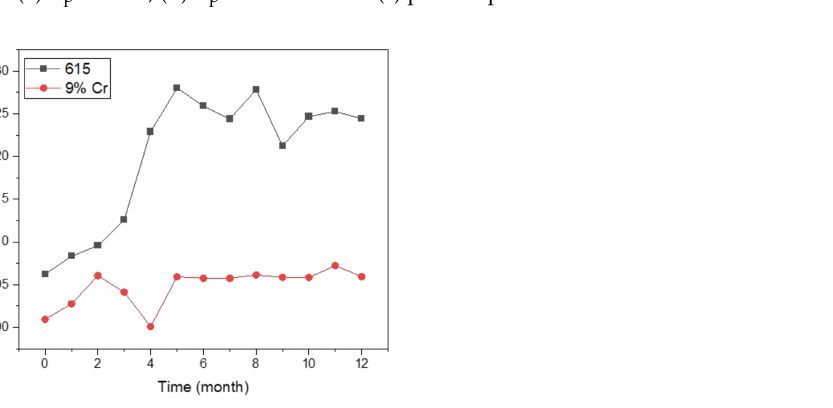
Figure 7. Summary of corrosion rate for both 615 and 9% Cr rebars in SCPS with 3.5 wt% NaCl as a function of